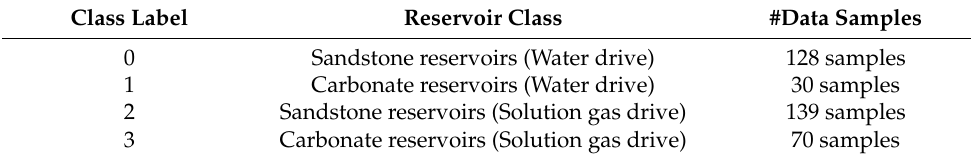
Table 1. Reservoir class types